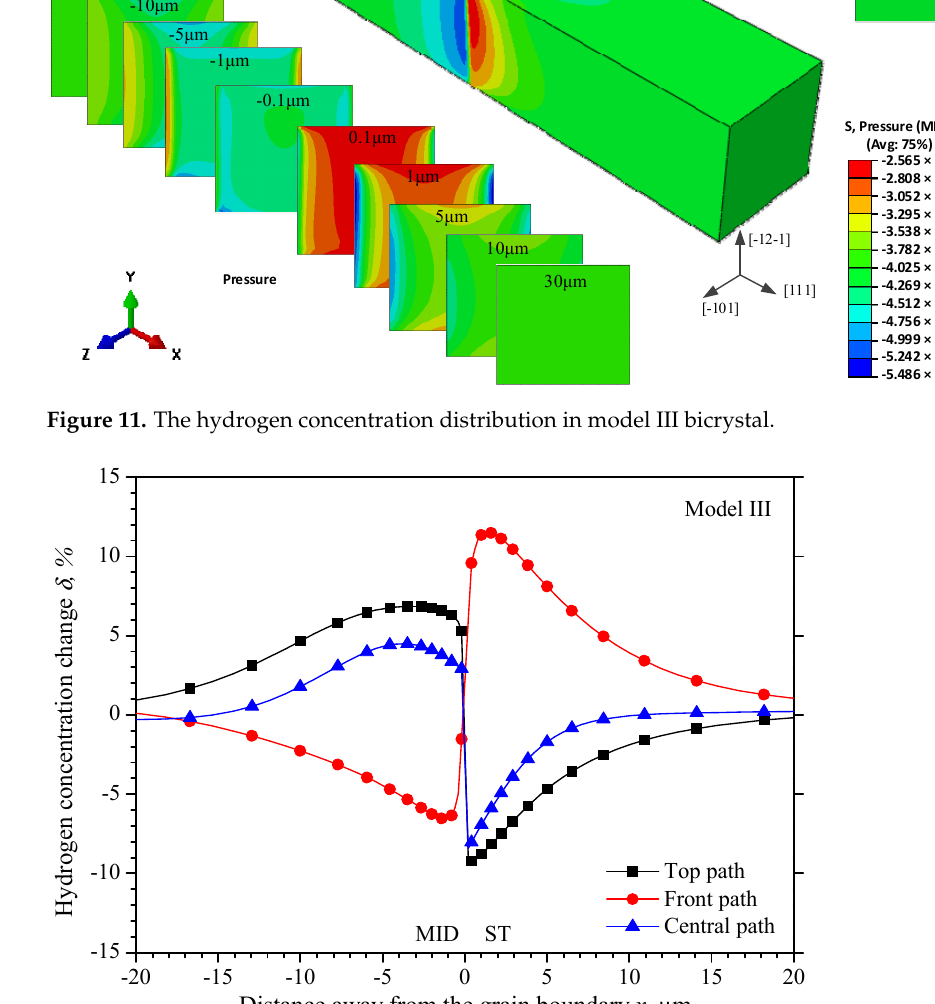
Figure 12. Hydrogen concentration change along observation paths in model III. In Figure 13, the maximum hydrogen concentration difference γ on the central path locates 0.2 µ m equidistant from the grain boundary, with a value of − 11.3%, while the maximum differences on the top path and the front path are − 15% and 18% within 1 µ m away from the grain